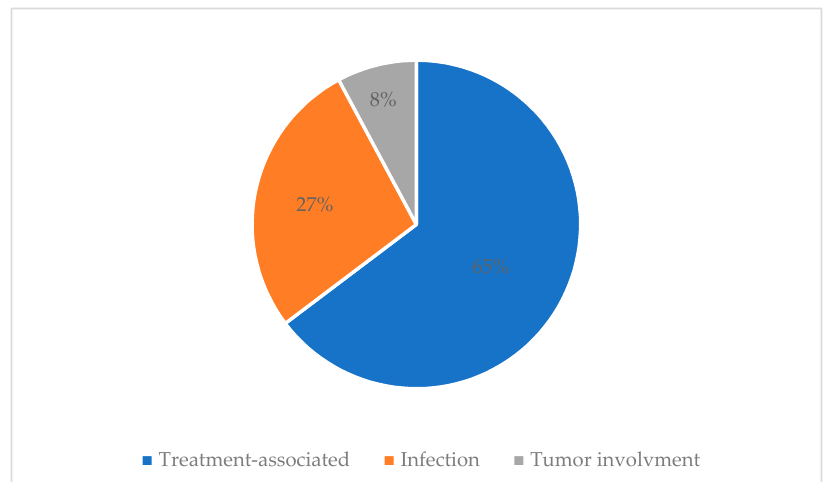
Figure 2. Causes of neurological complications.